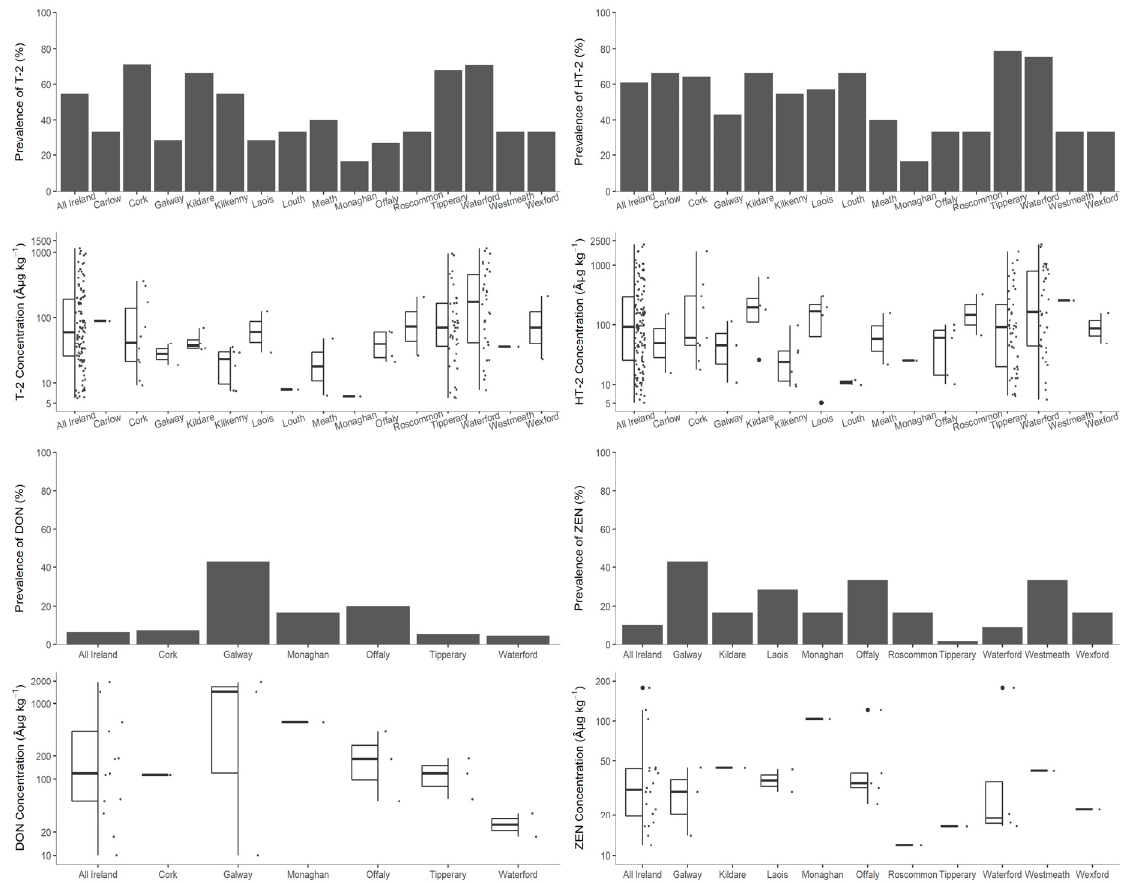
Figure 3. Prevalence and concentrations of deoxynivalenol (DON), HT-2 toxin (HT-2), T-2 toxin (T-2), and zearalenone (ZEN) by county.